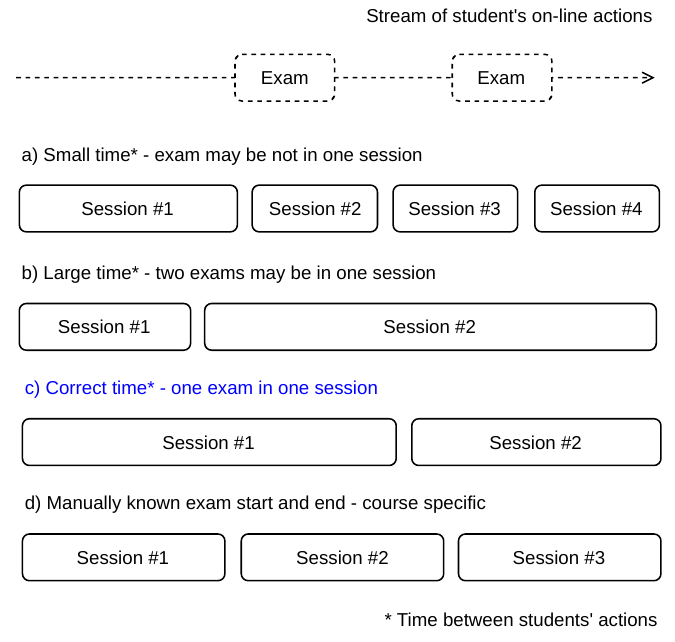
Figure 3. Splitting of student’s on-line action flow into